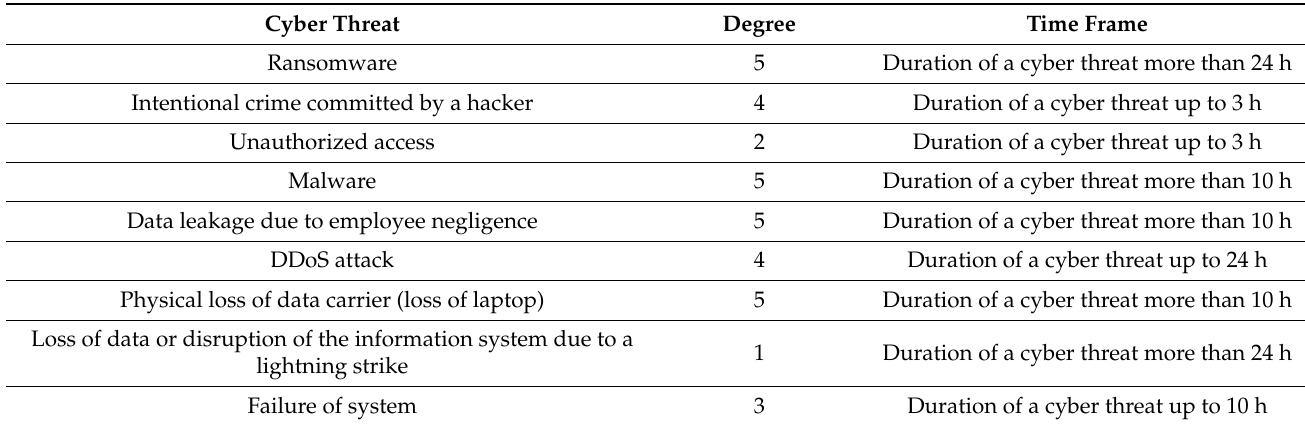
Table 5. Time frame degrees of cyber threat (own